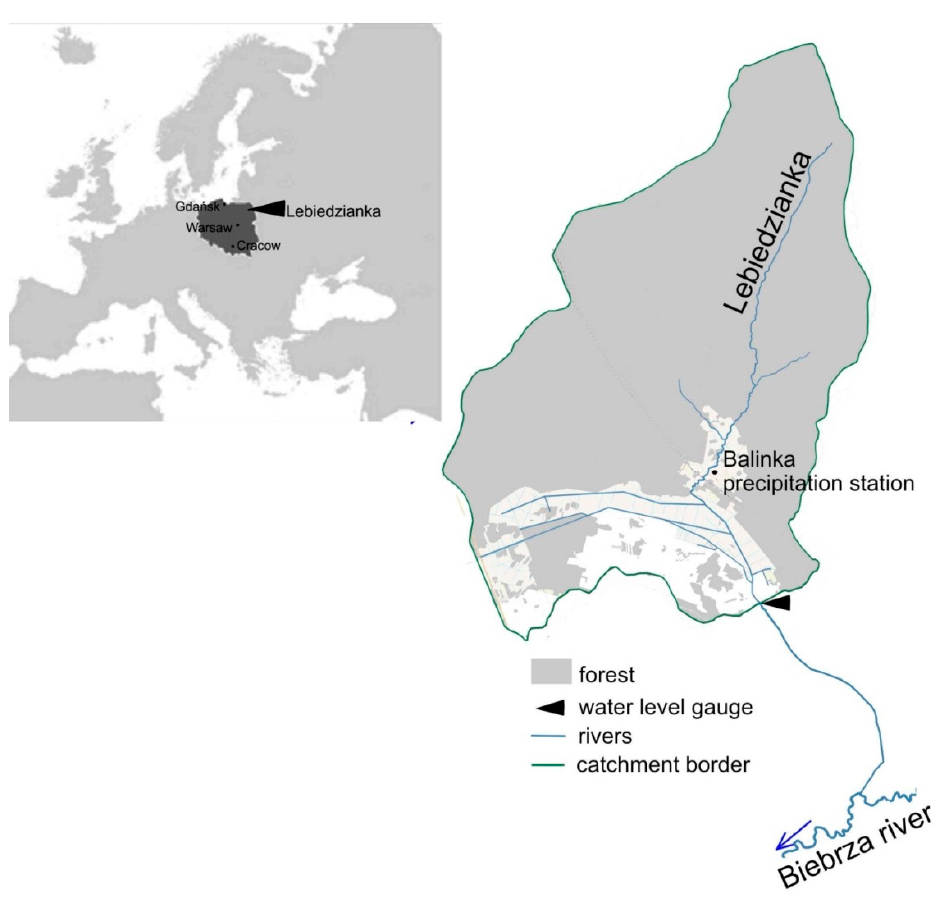
Figure 1. Location of the Lebiedzianka catchment.